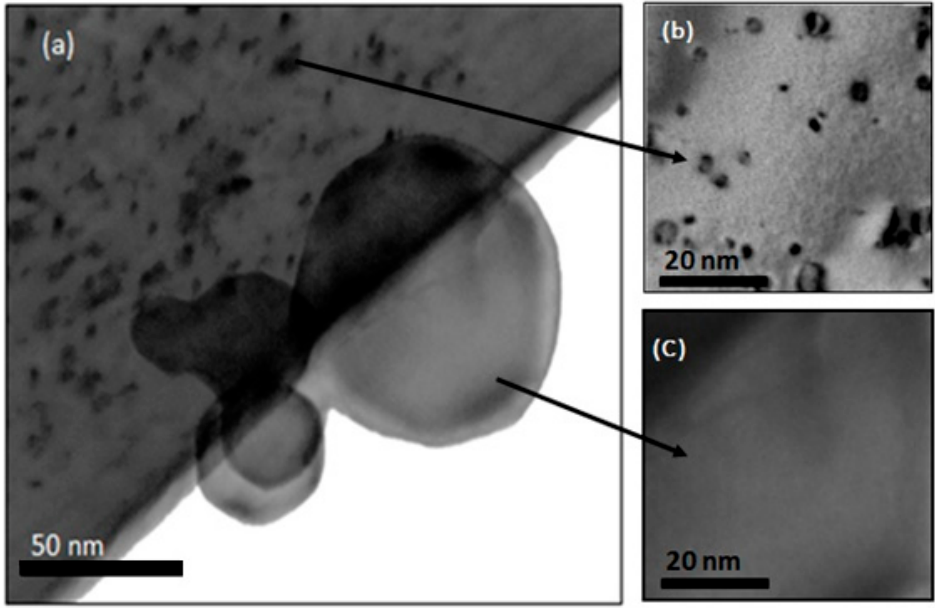
Figure 7. TEM images of: ( a ) NPs of different sizes and W foil irradiated to 1.1 × 10 17 ions · cm − 2 ; ( b ) enlarged area of the foil after tilting >15 ◦ to be close to a different zone axis to that shown in ( a ) to avoid any possible g . b invisibility criteria; and ( c ) enlarged area of NP after equivalent tilting of >15 ◦ . Note the complete absence of dislocation loops in the NPs evident in ( a ) and ( c ).